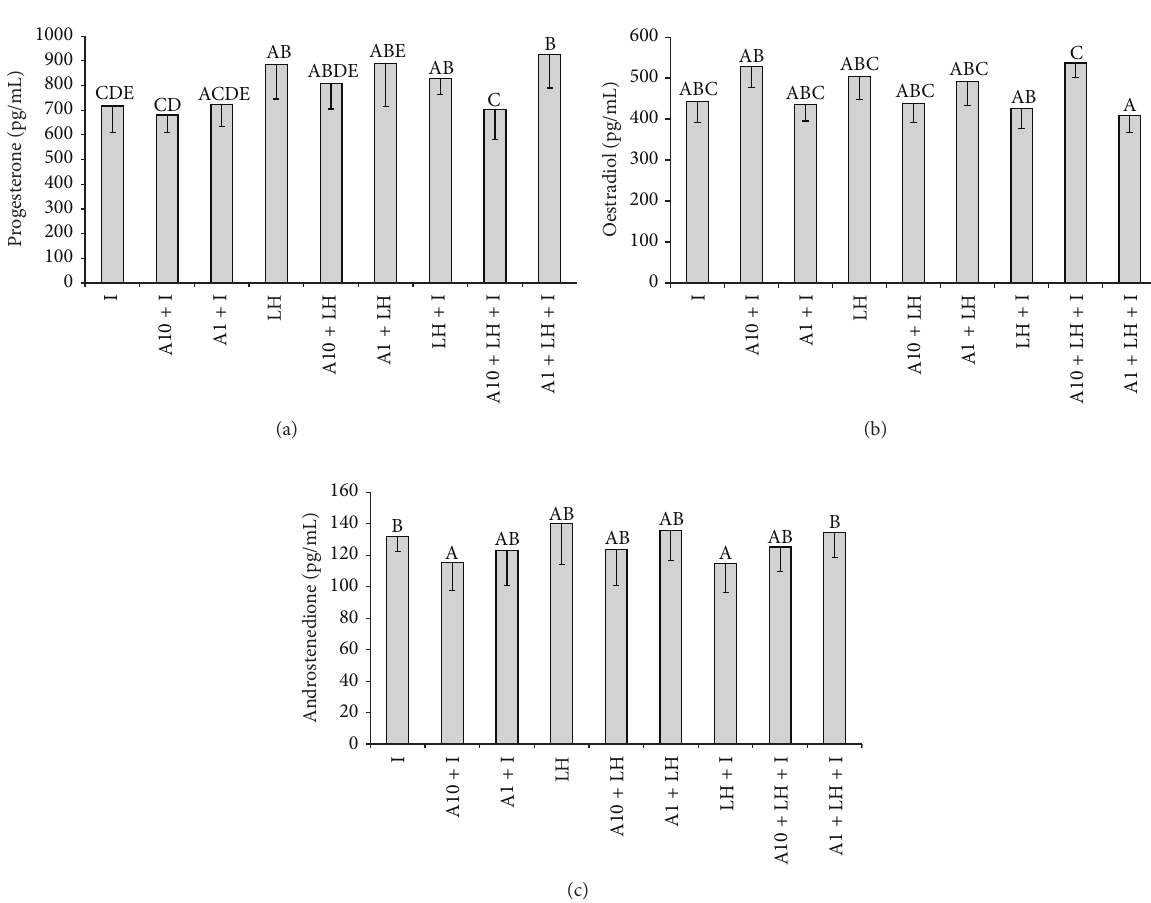
Figure 6: The effect of adiponectin (10 𝜇 g/mL-A10 and 1 𝜇 g/mL-A1) on insulin-stimulated (I; 10ng/mL) and/or LH-stimulated (10ng/mL) (a) progesterone, (b) oestradiol, and (c) androstenedione secretion by cultured theca interna cells collected on days 17–19 of the oestrous cycle. Bars with different superscripts are significantly different ( 𝑃 < 0.05 ). Results are means ± S.E.M. of five